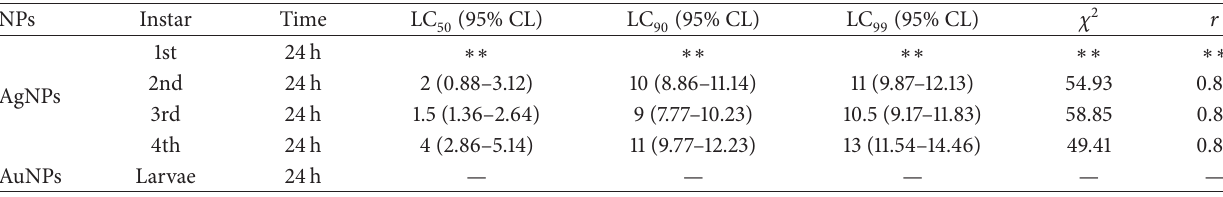
Table 2: Efficacy of silver nanoparticles and gold nanoparticles synthesized by bark extract of Cinnamomum zeylanicum against the larvae of Culex quinquefasciatus with their LC values, 95% confidential limits (CL), and 𝜒 2 and 𝑟 values after different time of